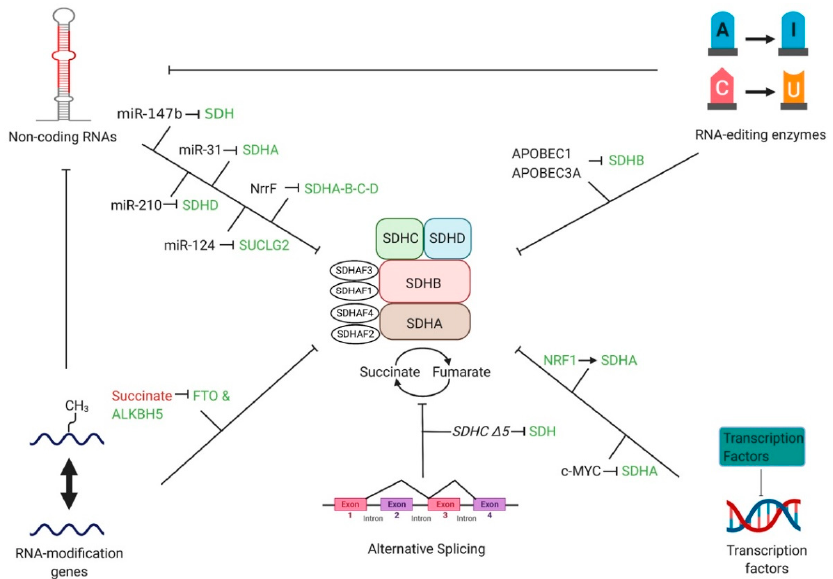
Figure 3. A network of RNA regulators interacting with succinate dehydrogenase. Different proteins/processes affecting the transcription/translation of the SDH complex are shown. For example, the RNA-editing enzyme APOBEC3A decreases the expression of SDHB. Similarly, the non- coding RNAs miR-31 and miR-210 decrease SDHA and SDHD activity, respectively. It is important to note that the interplay between RNA-editing enzymes and RNA-modification genes with non- coding RNAs has been established, but the possible role of these regulators and their effect on SDH has yet to be discovered and warrants intrigue. Regulations are signified with inhibition ( ┤ ) and promotion ( → ) together with upregulation (red lettering) and downregulation (green